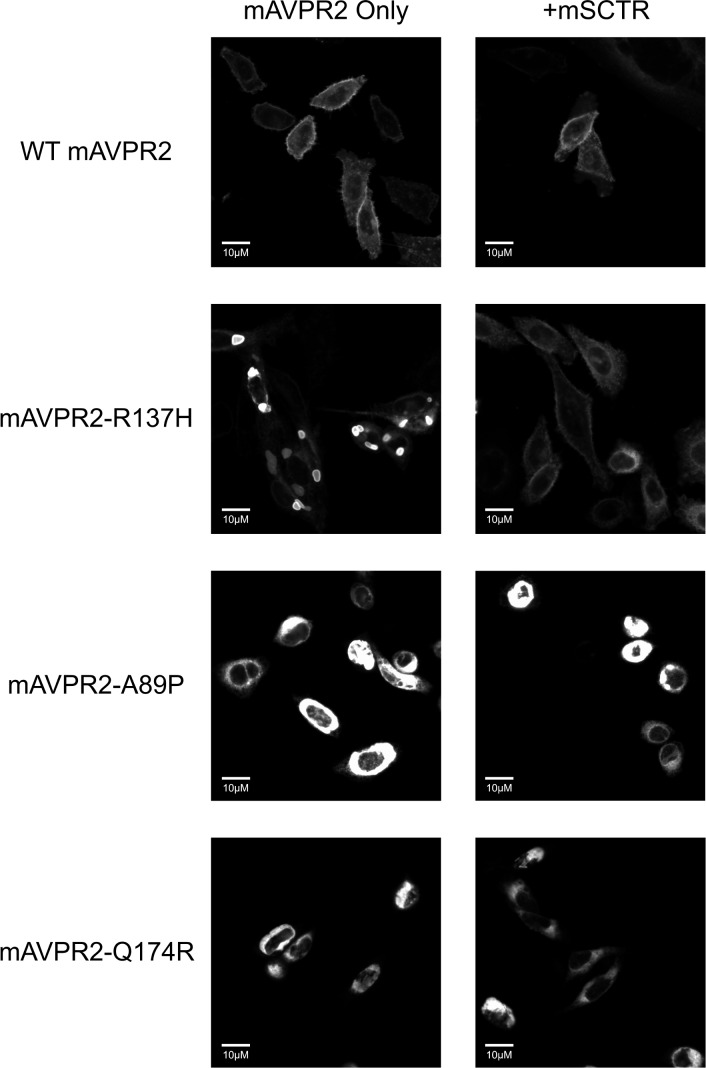
Rescue of the constitutively endocytosed R137H mAVPR2 mutant upon co-expression of mSCTR.Representative confocal images indicating the cellular location of mAVPR2-YFP receptors. The WT mAVPR2 is evenly distributed in the cell surface regardless of mSCTR co-expression. The R137H mutant is predominantly located in the intracellular endocytotic vesicles. Vesicular retention is not observed when mSCTR is co-transfected. The A89P and Q174R mutants cannot be rescued by mSCTR co-expression and remain intracellular. Scale bar, 10μM.